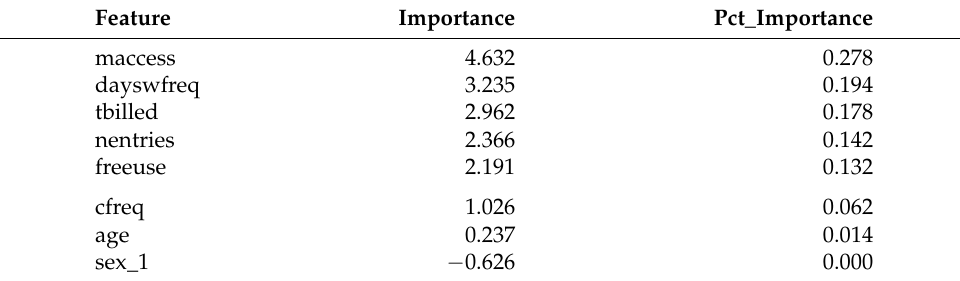
Table 6. Feature importance in the survival model with cluster 8.